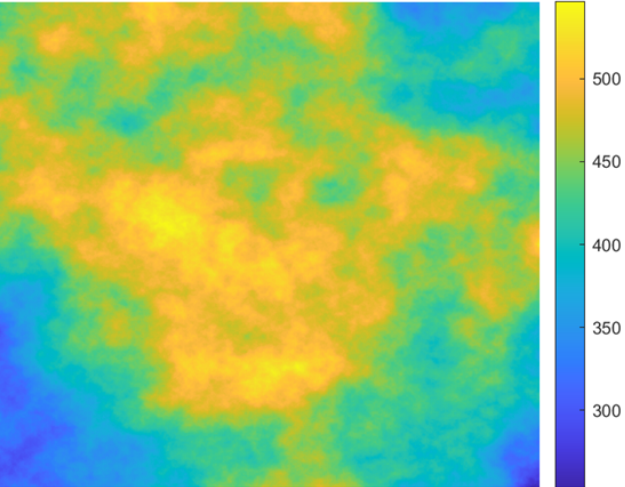
Figure 7. The simulated terrain of the experimental area; the maximum and minimum elevations are 550.0 m and 250.0 m,